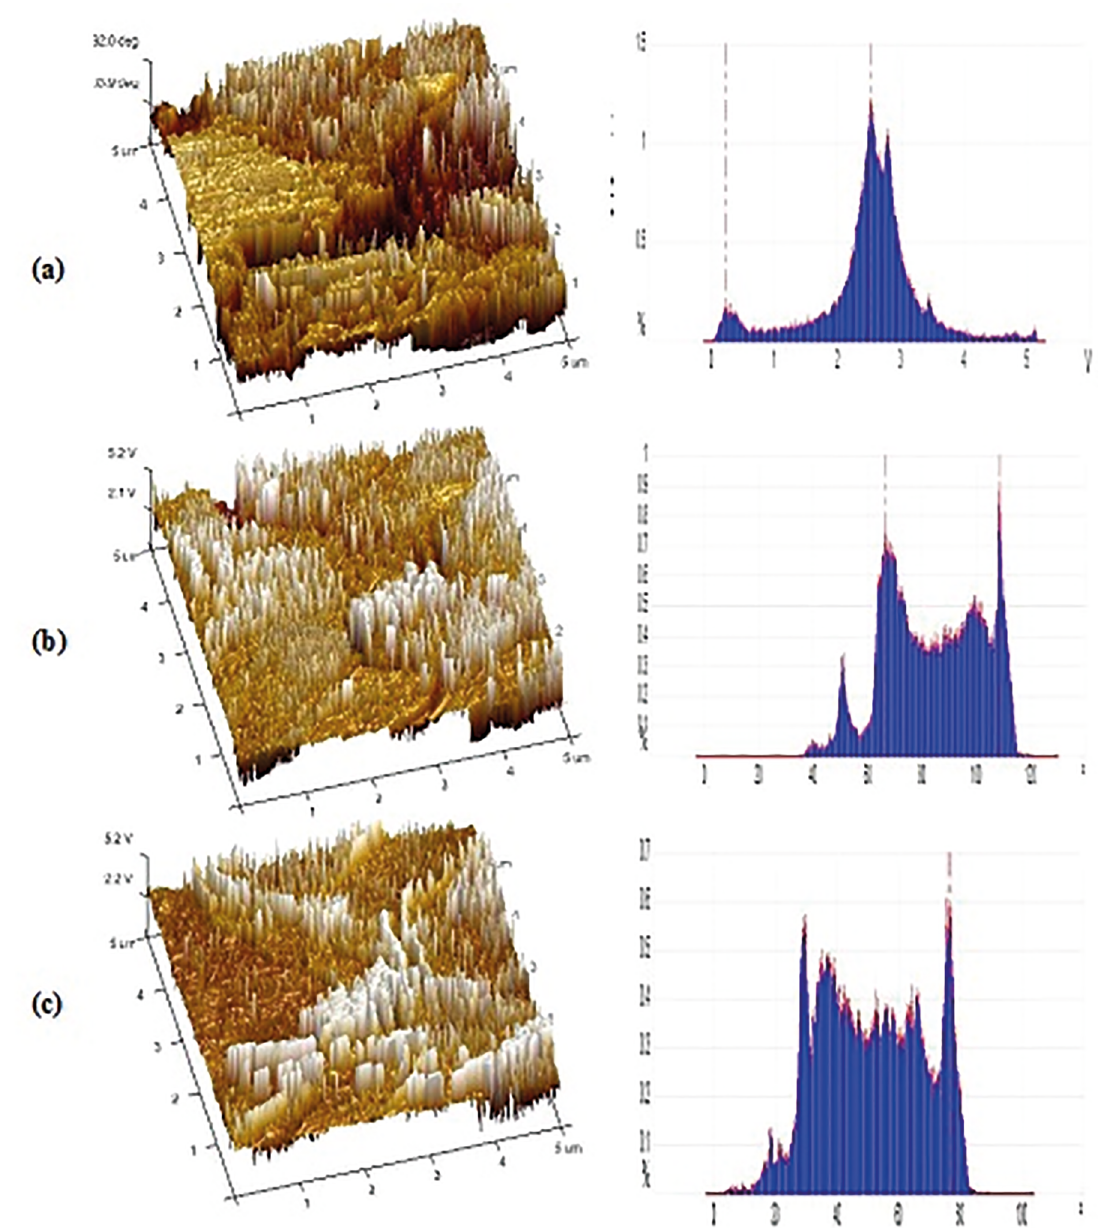
Figure 6. Average surface profiles, load 10 N and lubricated contact at 200 rpm after 60 min, at thickness (a) 15 ± 0.05 µm (b) 30 ± 0.05 µm and (c) 45 ± 0.05